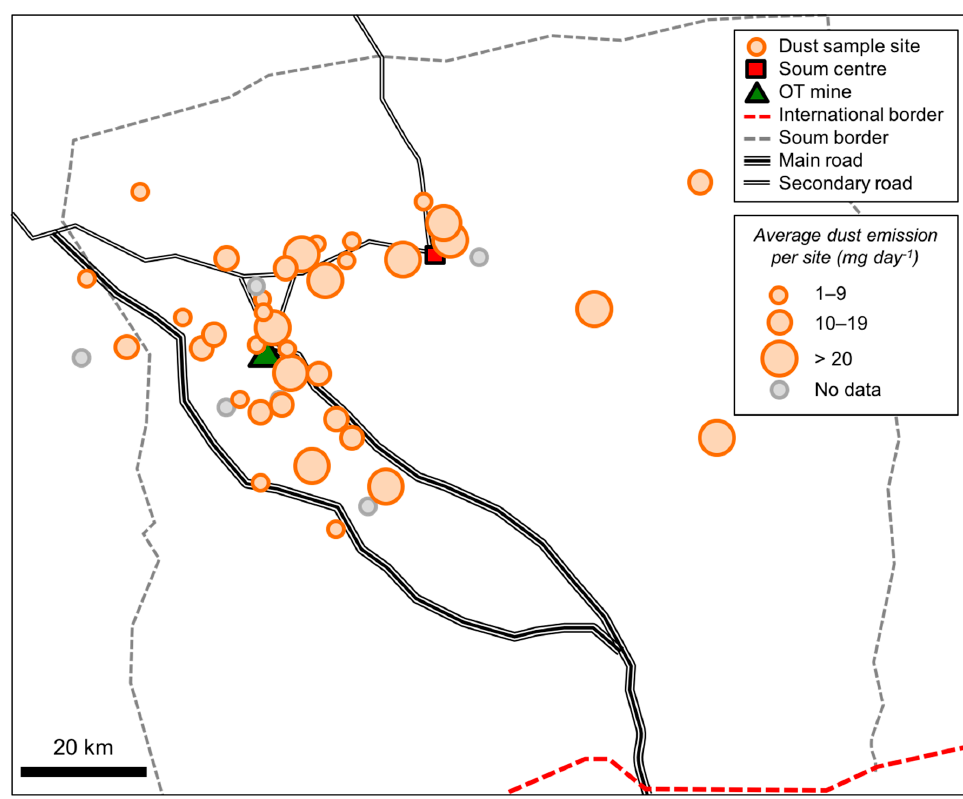
Figure 3. Distribution of dust emissions (mg day − 1 ) across the survey sites in Khanbogd soum . In general, dust was more prevalent at our sites in Nomgon bagh than in Javalant or Gavaluut baghs ( which are closest to the mine). Driving tracks were as much as 75 m wide in Javalant bagh and 55 m wide in Bayan bagh as vehicles choose alternate tracks depend- ing on conditions. In the absence of paved roads, traffic creates multiple “braided” tracks across the landscape. In comparison, the (then unpaved) OT-Khanbogd road is 11 m wide with 2–4 m soft edges. Heavy truck traffic on the road to China (particularly coal transport) on dirt tracks, creation of new tracks and digging up of riverbeds for local con- struction material can instigate erosional processes and provide source material for dust transport. Our methods do not allow the initial source of the dust to be ascertained, but it is likely that several other potential dust sources exist beyond mining and road traffic: quarries and dirt pits, construction of a railway and new powerline, dry riverbeds and areas of livestock concentration. Moreover, large-scale dust events also occur, which can have landscape-wide impacts. An example during our field season is that the local Khan- bumbat airport was temporarily closed due to dust storms on 22 May 2016. Results from the aerosol optical depth (AOD) analysis (Figure 4) show high variabil- ity in dust presence throughout the 2000s. This may be associated with mine site develop- ment and transport from Tavan Tolgoi on unpaved roads. High dust levels were observed in the soum from 2005 to 2010 ( 𝜇 = 0.22, 𝜎 = 0.11), which may be linked to operational de- velopments at OT, and this was followed by a steep decline after the autumn of 2010 ( 𝜇 = 0.17, 𝜎 = 0.06). There is significant intra-annual variability resulting from local wind pat- terns and strengths, with higher dust levels occurring in spring (MMA, 𝜇 = 0.28, 𝜎 = 0.07) and lower levels in autumn (SON, 𝜇 = 0.13, 𝜎 = 0.03). On NASA’s scale of 0.1 being very clear and 0.4 being very dusty [42], dust levels in the past few years have largely remained at satisfactory levels, though levels reach higher in late 2015. Whilst evaluating the impact